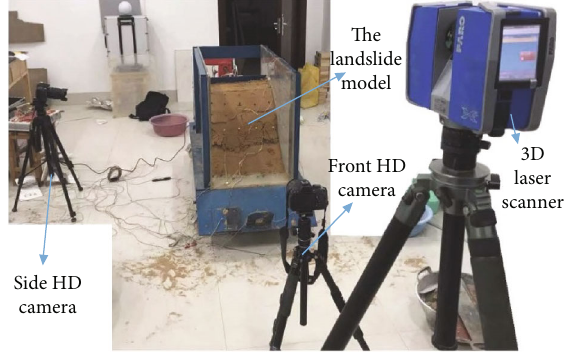
Figure 4: Landslide model and instruments layout.